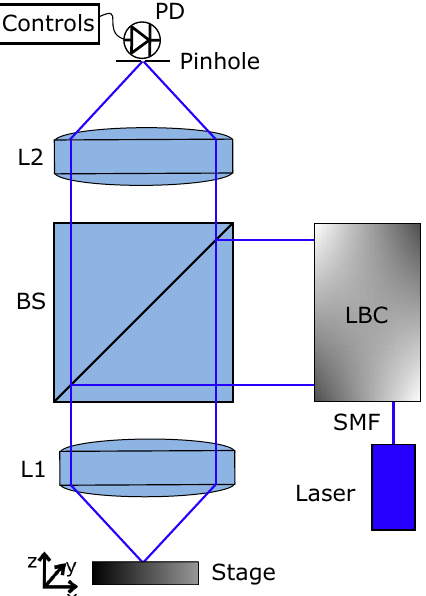
Figure 2. Schematic drawing of the reflection confocal laser scanning microscopy (CLSM); Laser: laser diode λ = 405nm, SMF: single-mode fiber, LBC: large beam collimator, BS: 50% beam splitter, L1: aspheric lens, L2: plan achromat objective, PD: photodiode, Controls: transimpedance amplifier, Newport XPS with A/D converter and PC with